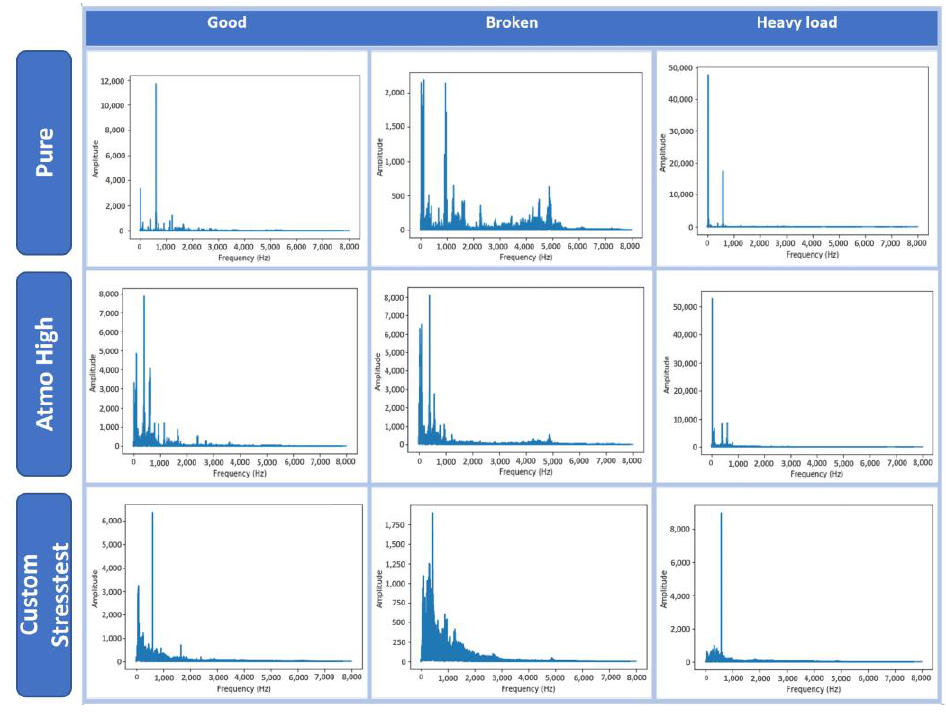
Figure 1. Frequency responses of audio signals.